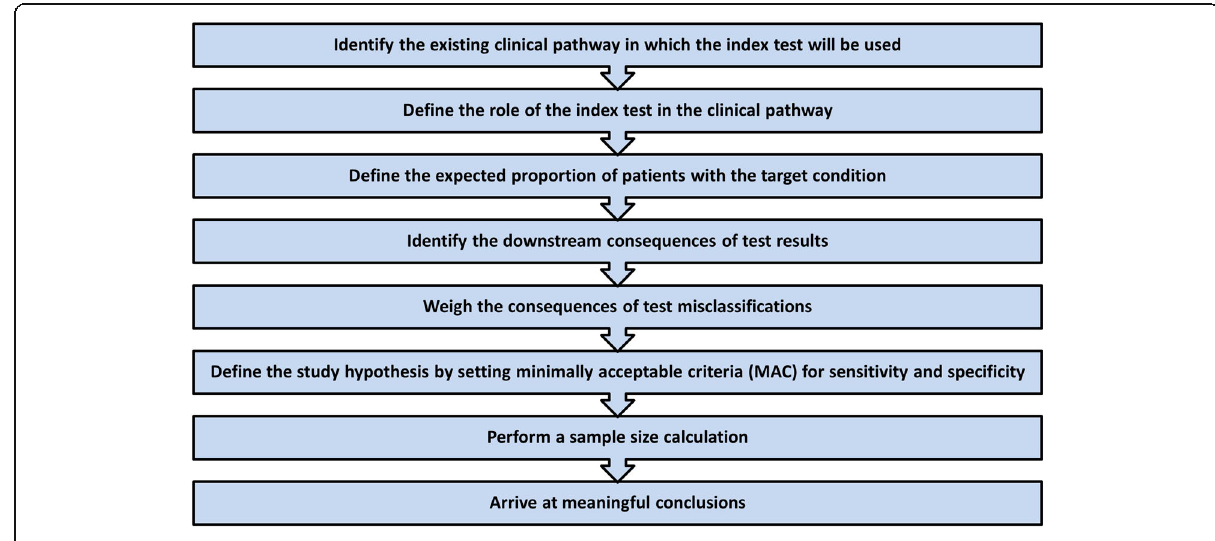
Fig. 3 Defining minimally acceptable criteria (MAC) for diagnostic